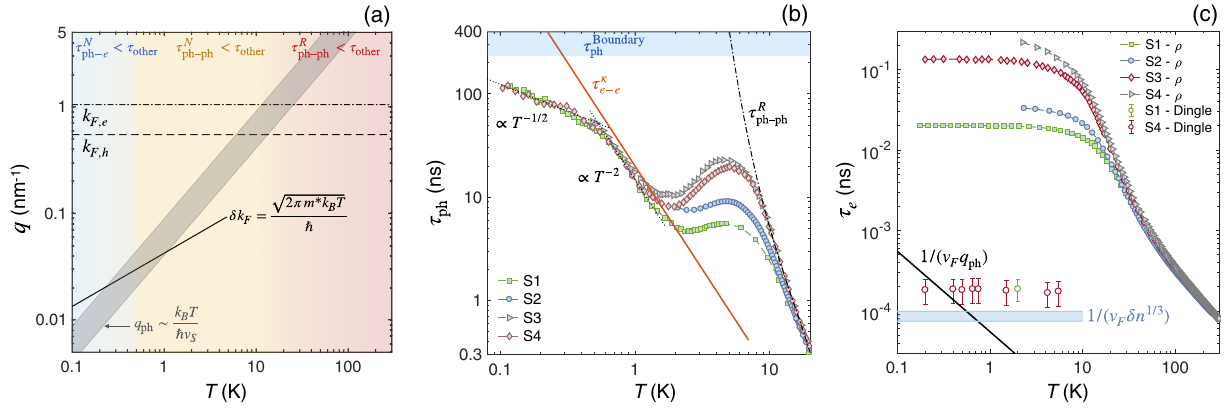
FIG. 7. Hydrodynamic regimes. (a) Evolution of the different wave vectors as a function of T . Three different regions are identified. (b) Temperature dependence of the phonon scattering time extracted from the thermal diffusivity of four samples as a function of T . Above T ≈ 15 K, momentum-relaxing ph-ph collisions dominate. For 1 < T < 15 K, momentum-conserving ph-ph collisions lead to a size-dependent decrease in the effective scattering time. Below T ≈ 1 K, the most frequent events are momentum-conserving e -ph collisions, and the phonon scattering time is close to the e - e scattering time extracted from κ e . (c) Temperature dependence of the electronic scattering time extracted from the electrical resistivity of four samples alongside the Dingle scattering time for samples S1 and S4. Also shown are the typical time between e -ph collisions (solid black line) and the typical time of electron-defect collisions estimated from the Hall resistivity (see Supplemental Material for details